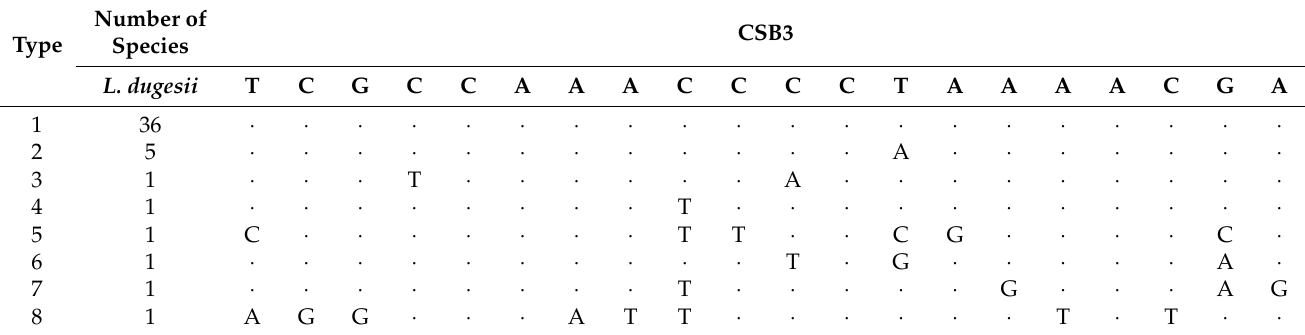
Table 7. Type of conserved structure element of CSB3 in